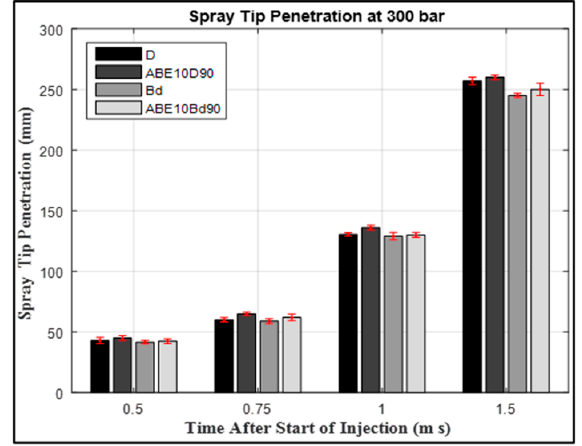
Figure 5. Spray tip penetration of test blends.